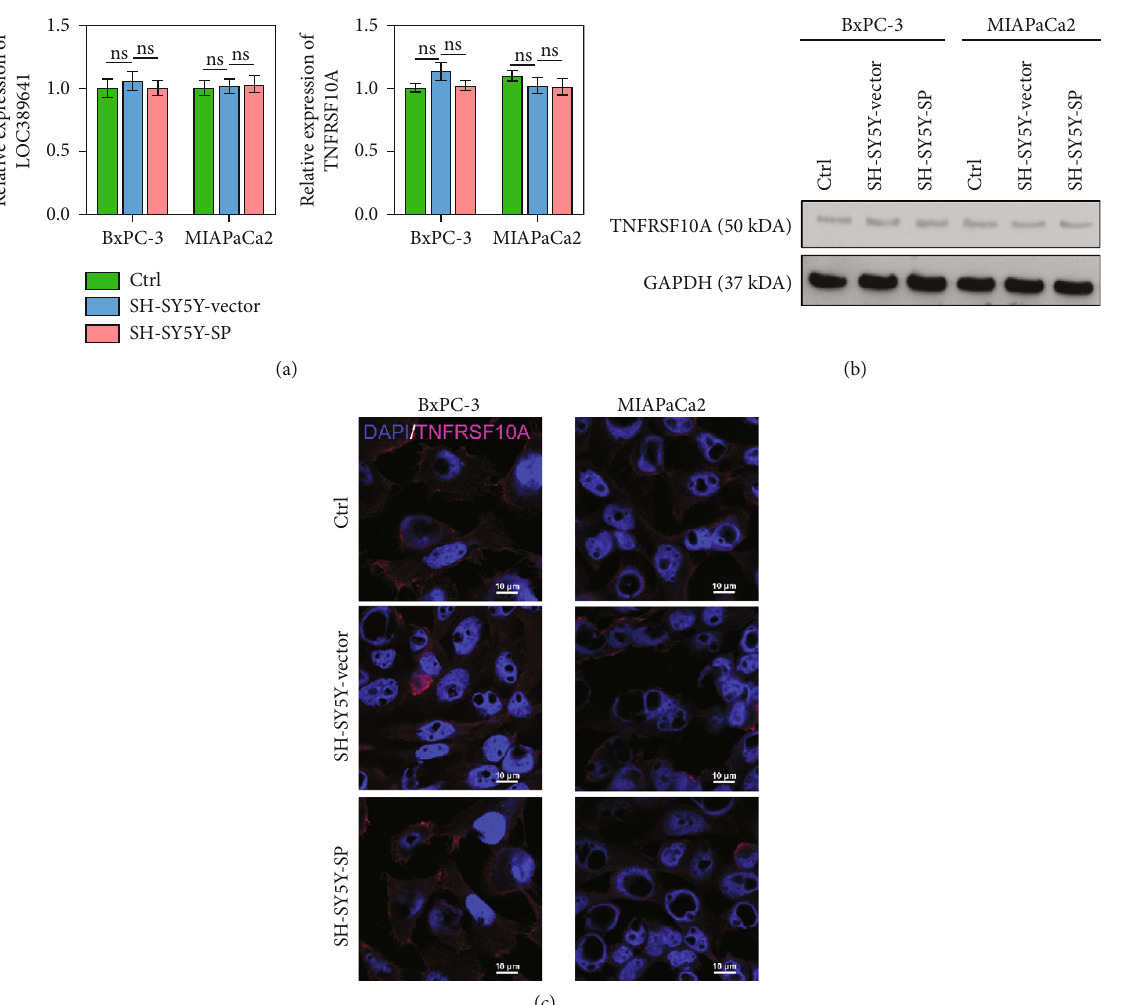
Figure 5: lncRNA LOC389641 expression and TNFRSF10A mRNA expression were not a ff ected by SP. (a) The levels of lncRNA LOC389641 expression and TNFRSF10A mRNA expression were evaluated by RT-PCR. (b, c) The levels of TNFRSF10A protein expression were assessed by western blotting and